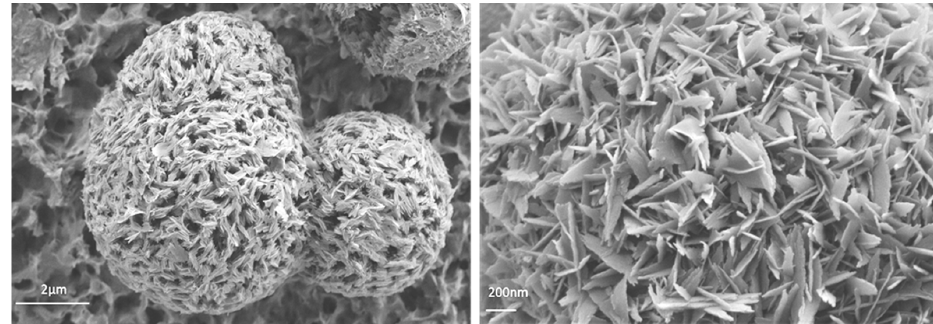
Figure 6. CIM-80_8.5 FESEM micrographs.